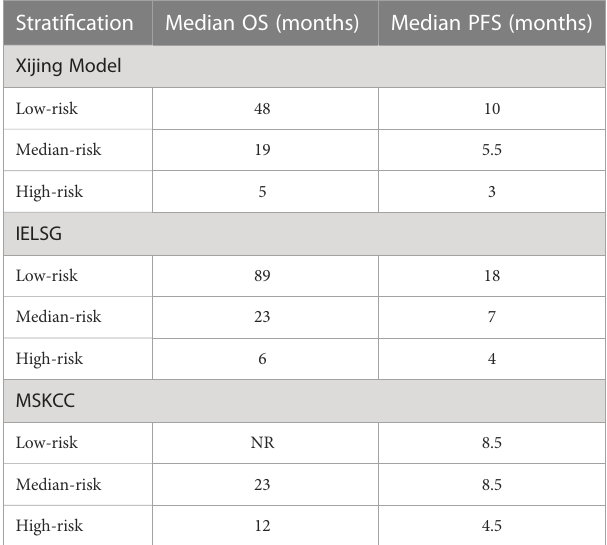
TABLE 5 The OS and PFS of different strati fi cations in the development